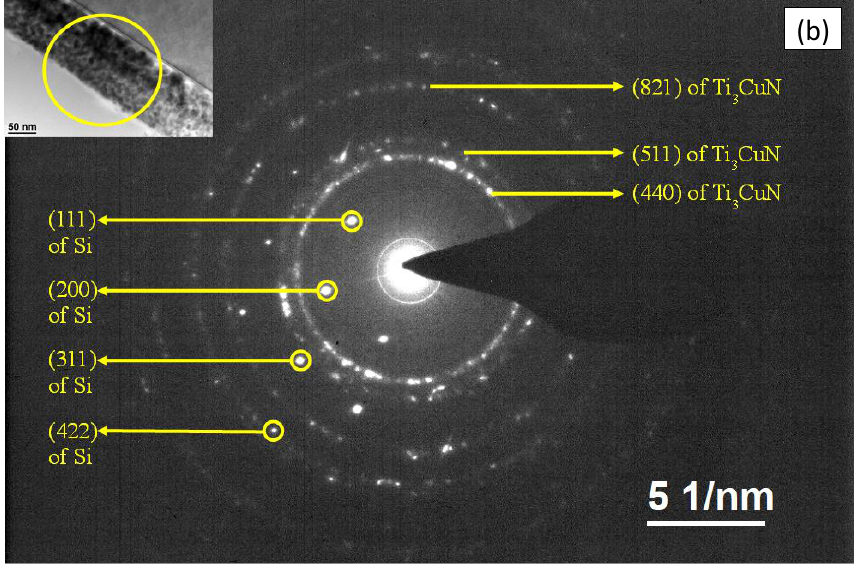
Figure 11. ( a ) HRTEM image, ( b ) SAED pattern of Ti x -Cu y N z film. Insert shows investigated